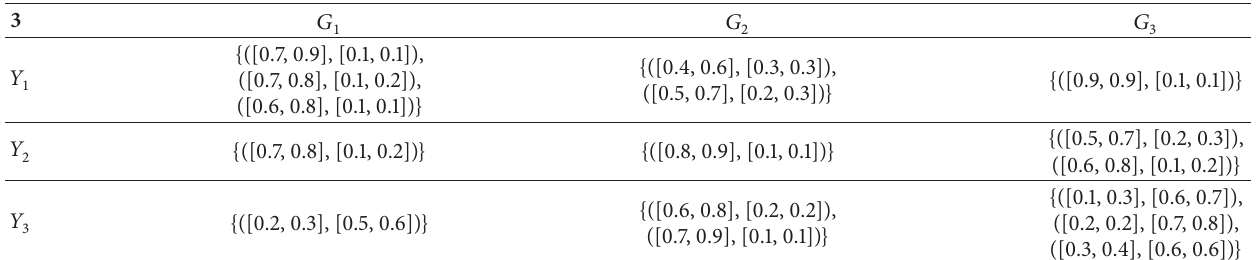
̃𝑅 (2) provided by 𝐷 2 .